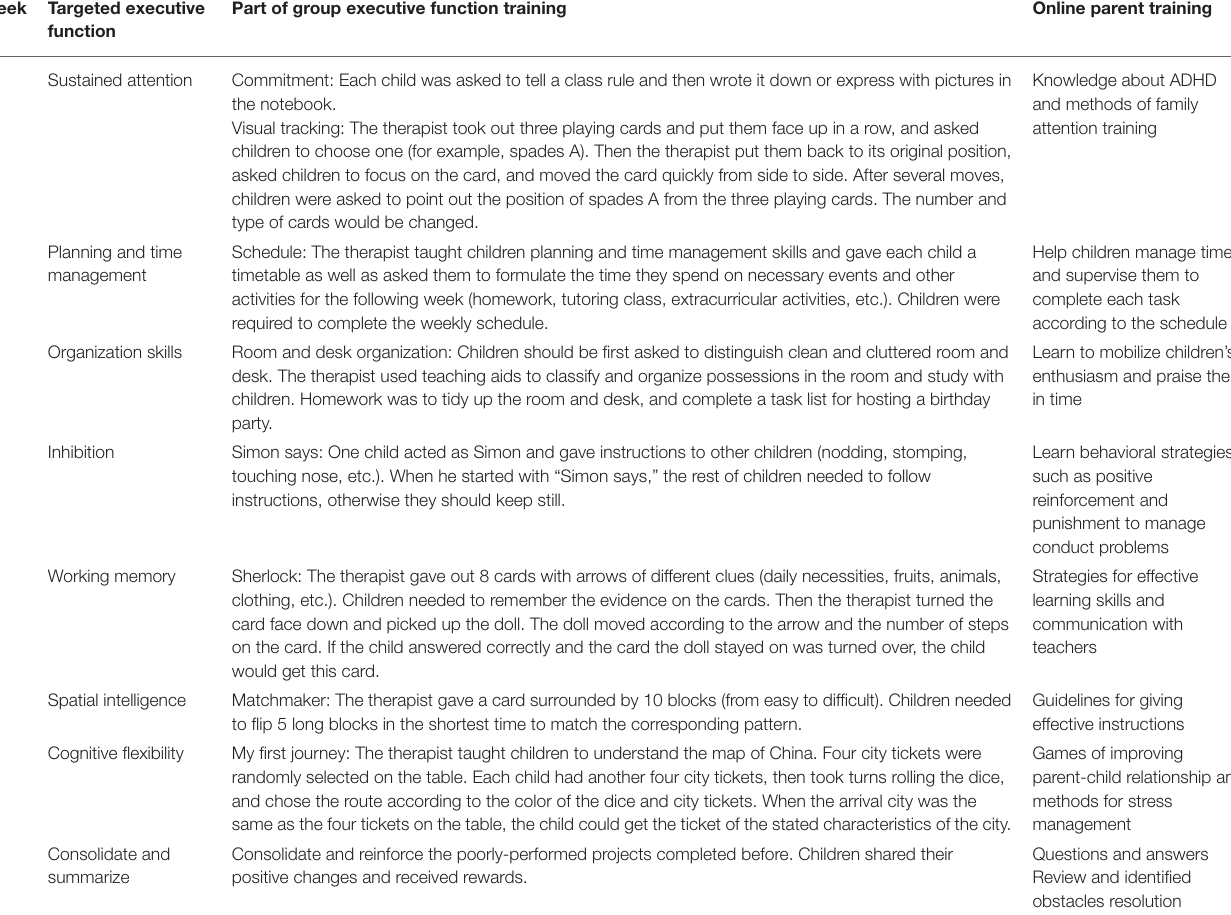
TABLE 1 | Contents of GEF-OPT. Week Targeted executive Part of group executive function function